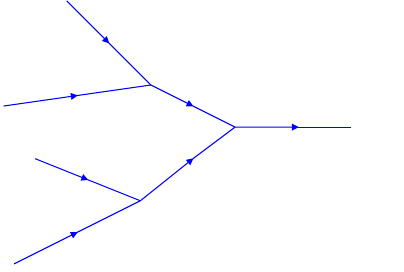
Figure 3. Stream segmentation procedure network connectivity